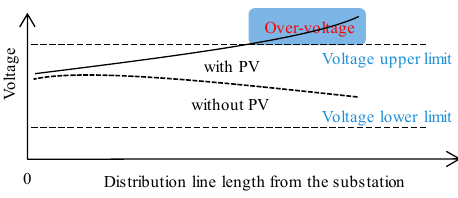
Figure 2. Diagram of an over-voltage profile.